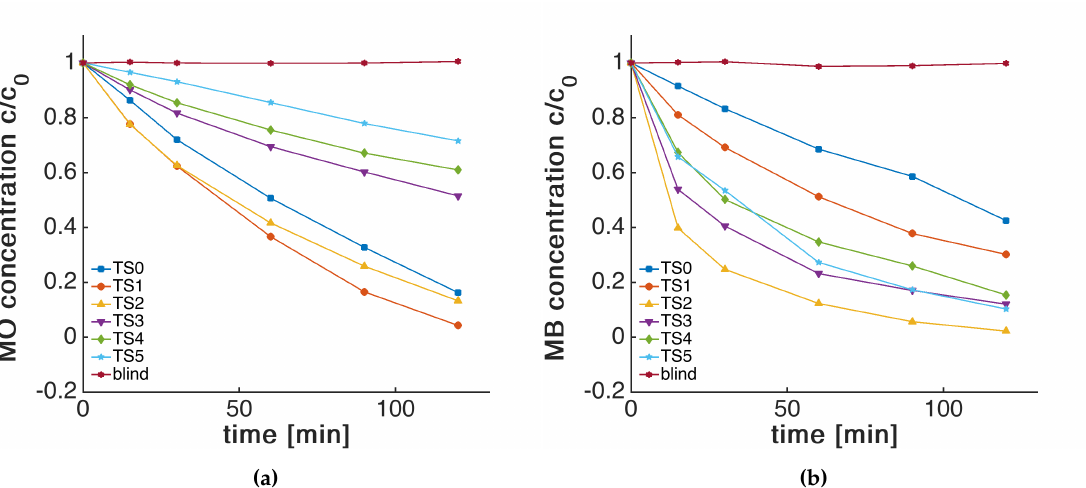
Figure 5. Photocatalytic degradation of a blind and different core-shell samples on the ( a ) methyl orange (MO) degradation and the ( b ) methylene blue (MB)